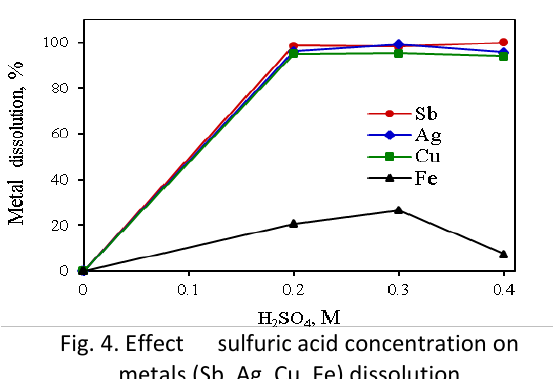
copper, silver and